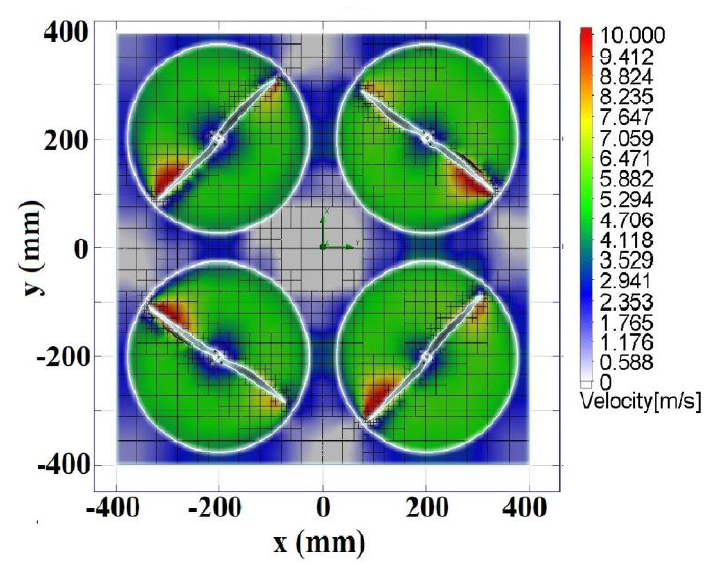
Figure 3. Air velocity